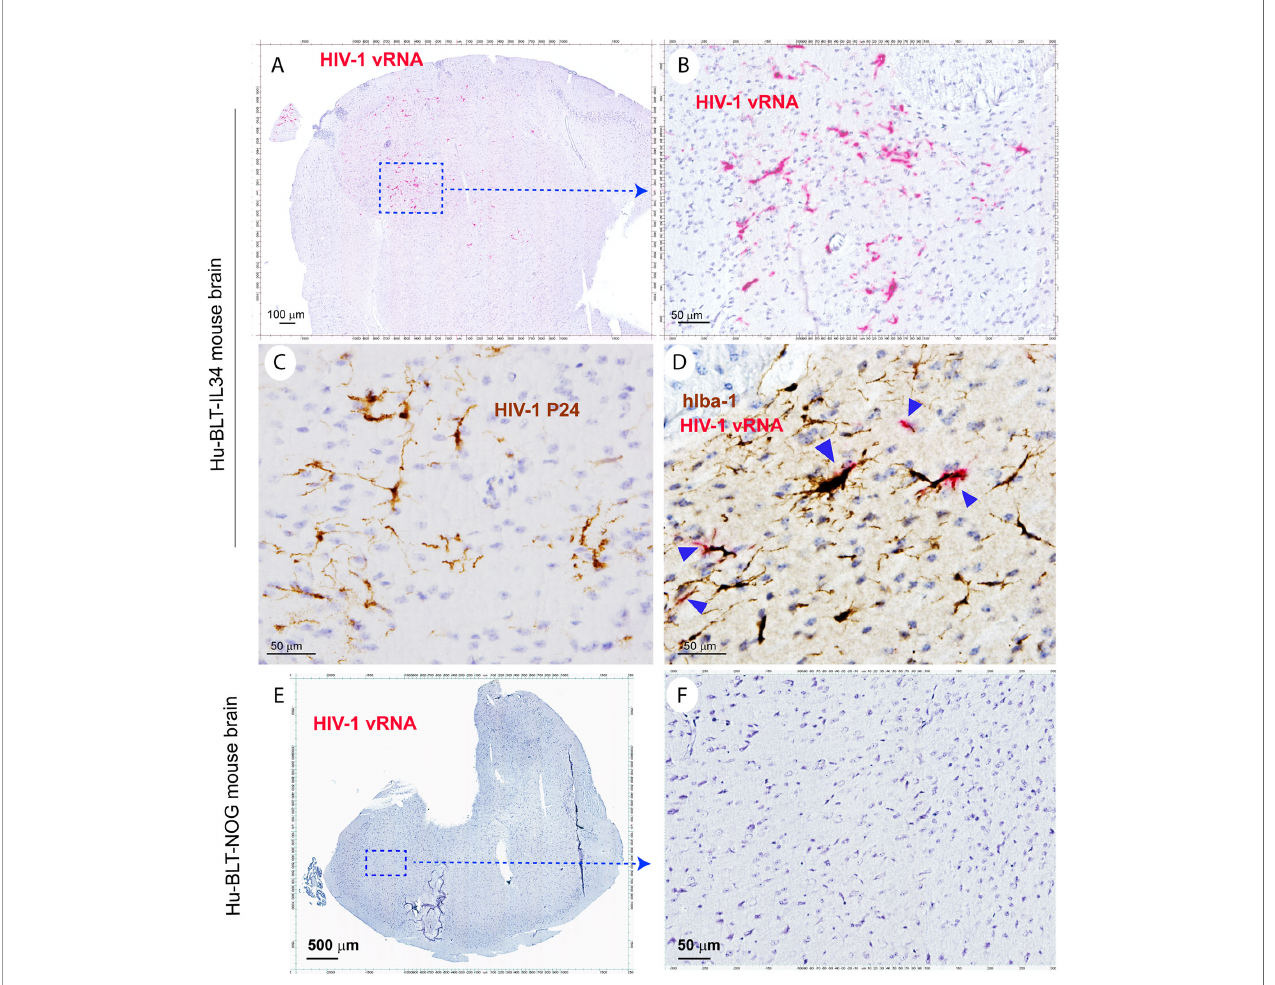
FIGURE 5 | The HIV-1 infection of human microglia of hu-BLT-hIL34 mice. The Upper panel shows HIV-1 RNA+ cells ( A, B , red) in a representative whole brain tissue section from a hu-BLT-hIL34 mouse (#1708) that was detected using RNAscope in situ hybridization with HIV-1 clade B anti-sense probe and counterstained with hematoxylin. The highlighted boxed region from the Figure (A) was shown at a higher magni fi cation of HIV-1 RNA+ cells ( B , red). HIV-1 p24+ cells ( C , brown) in the cerebral cortex of the same mouse were detected using IHCS. The colocalization of HIV-1 vRNA and human myeloid cell marker hIba-1 ( D , arrows) indicating the reconstituted human myeloid cells could support HIV-1 replication. The lower panel (E, F) shows there were no detectable HIV-1 RNA+ cells in a representative whole brain tissue section from a hu-BLT mouse (#1724) using RNAscope in situ